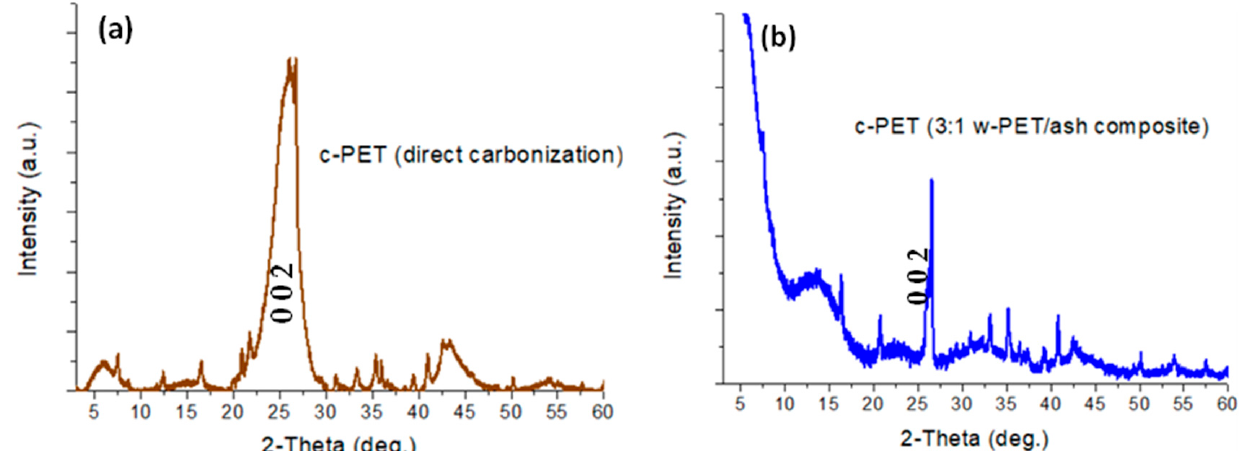
Figure 5. PXRD pa tt ern of c-PET powder samples measured from 2-Theta 3–60° at a scan rate of 2°/min: ( a ) c-PET from direct carbonization of w-PET; ( b ) c-PET from co-carbonization of 3:1 w-PET/ash composite.